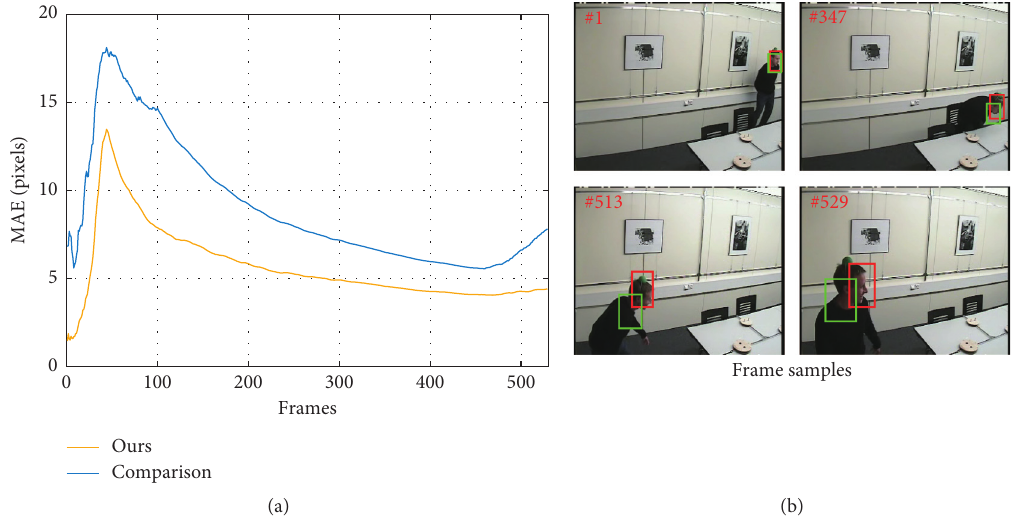
Figure 4: (a) MAE on image plane (pixels). (b) Tracking results on frame samples from seq11c1 produced by comparison method (green) and our method